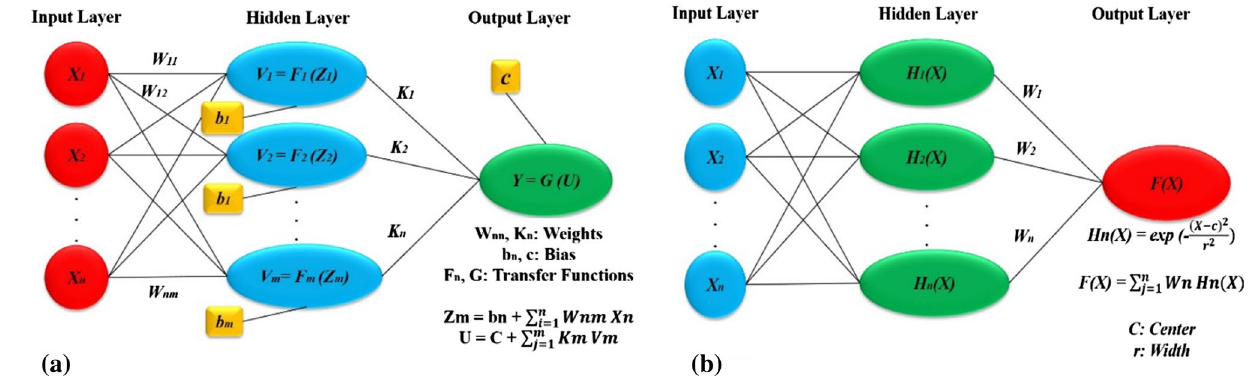
Fig. 2 A simple composition of a MLP and b RBF neural